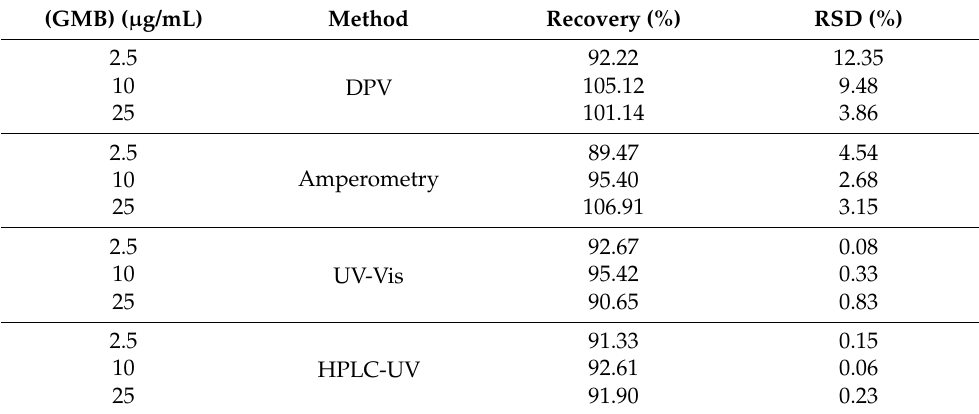
Table 3. Results obtained with the electrochemical methods optimized, UV-Vis spectrophotometry and HPLC-UV for solutions prepared from the GMB-concentrated solution for infusion. (GMB) ( µ